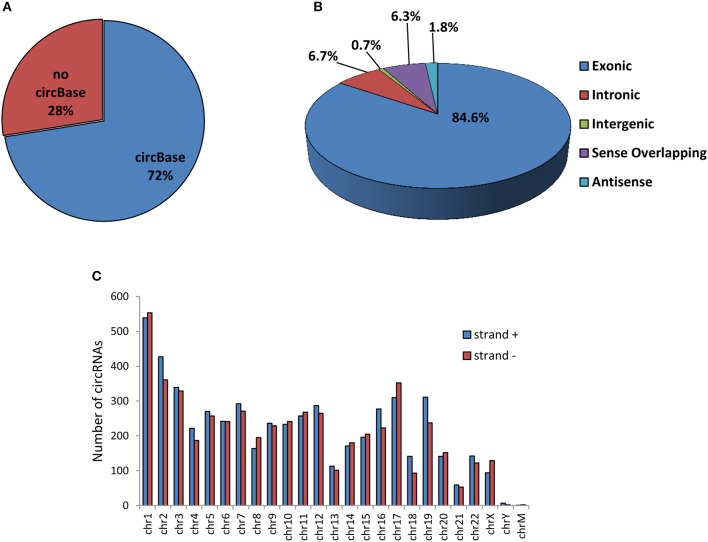
Overview of circRNA expression in human SPZ (A) The proportion of circRNAs from circBASE (www.circbase.org) and other databases/literatures on a total of 10,726 circRNAs identified. (B) The proportion of different types of circRNAs among all predicted circRNAs. (C) Chromosomal distribution of SPZ derived circRNAs, on strand + and strand –.